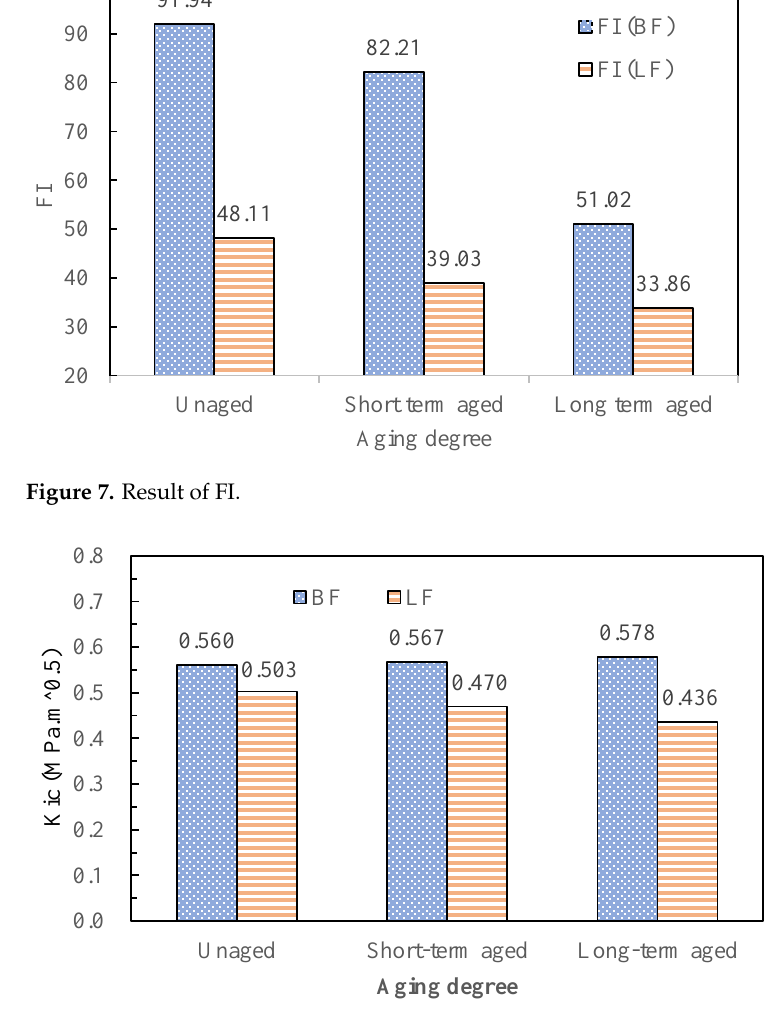
Figure 8. Result of K IC .